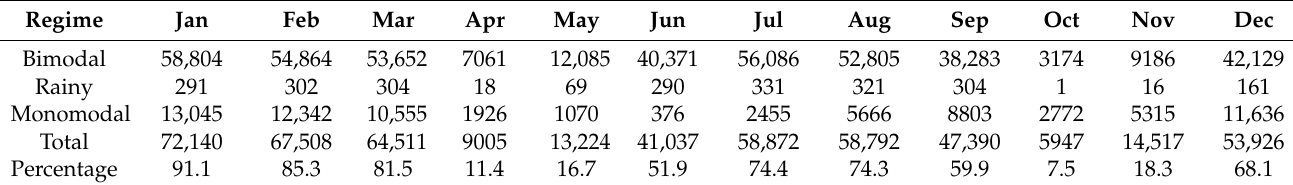
Table 2. Area classified in water deficit in PPA (potential production area in Colombia) by month (km 2 ). Regime